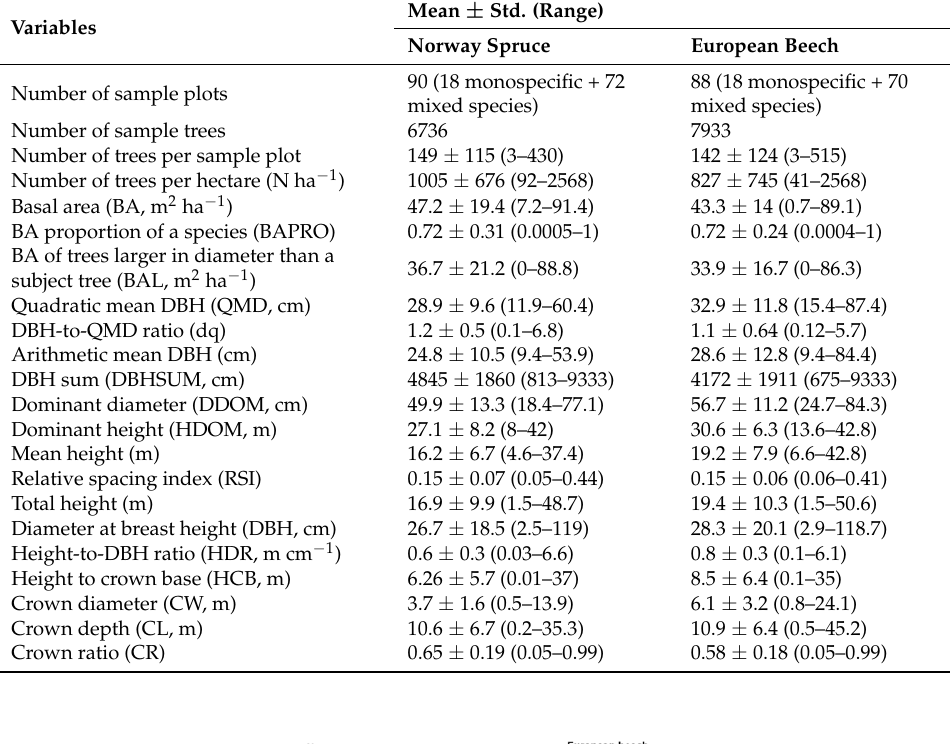
Table 1. Summary statistics of data.